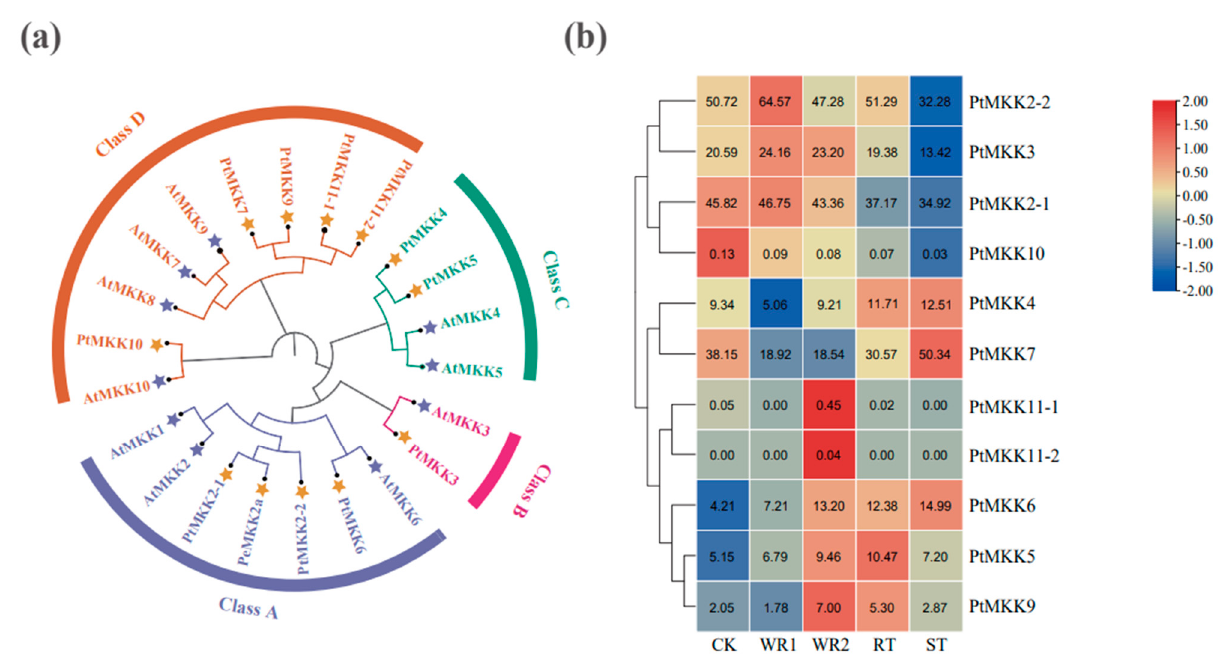
Figure 2. ( a ) Phylogenetic relationships of A. thaliana and P. trichocarpa MKK proteins. ( b ) Hierarchical clustering of the expression profiles of 10 MAPKK gene family members for different development periods and tissues in P. trichocarpa (CK, stem segment; WR1, one − week − old roots; WR2, two − week − old roots; RT, root tips; ST, stem tips) .